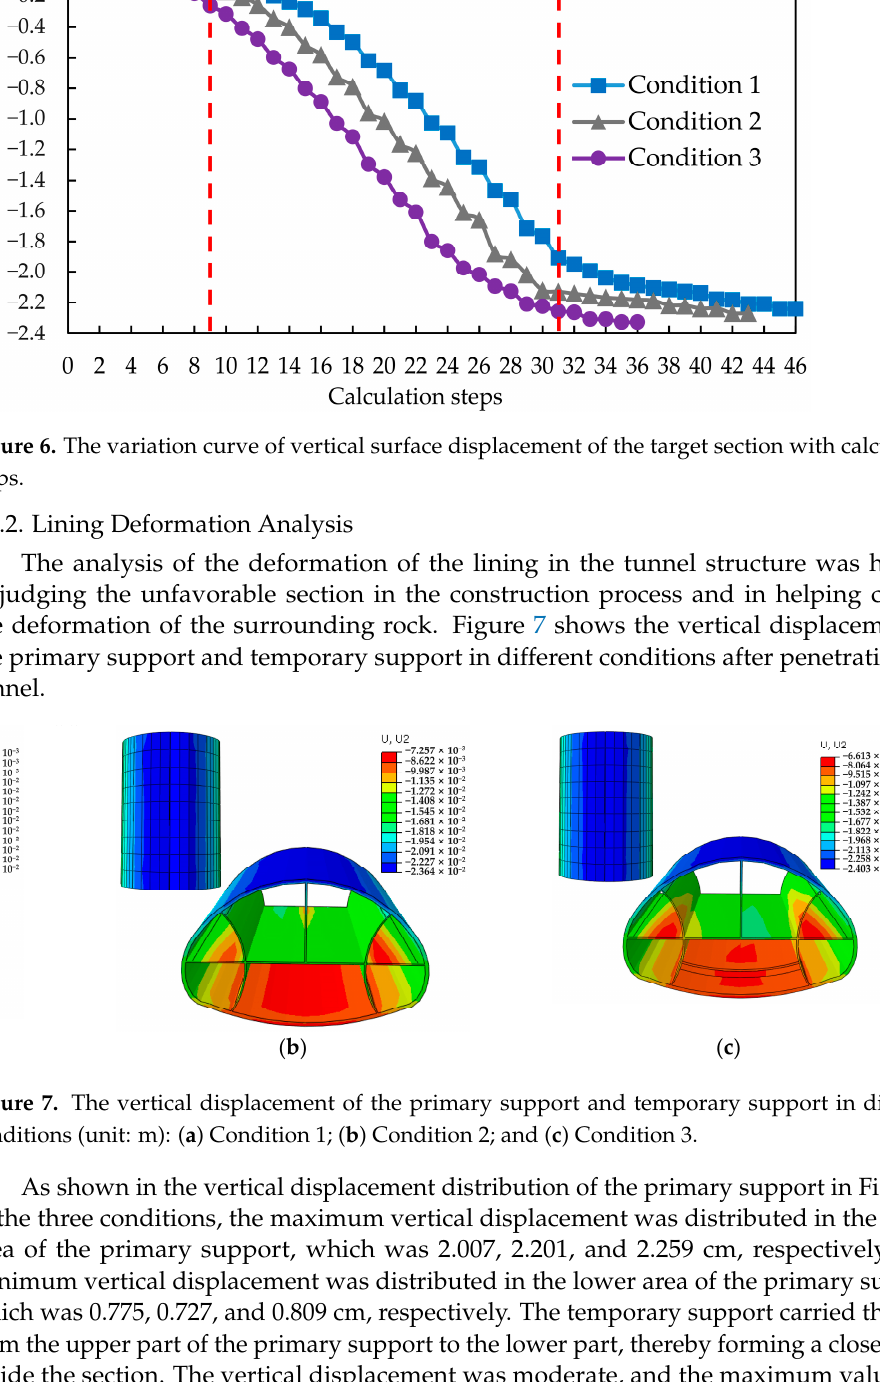
( d ) Figure 5. Vertical displacement of surrounding rock at the target section of rock mass part excava- tion under Condition 1 (unit: m): ( a ) Excavation of the right pilot tunnel; ( b ) Excavation of the left pilot tunnel; ( c ) Excavation of the upper part of the middle pilot tunnel; ( d ) Excavation of the lower part of the middle pilot tunnel. Figure 6 shows the variation curve of the vertical surface displacement of the target section with calculation steps in various working conditions. As seen in Figure 6, after the initial ground stress balance, the surface settlement gradually increased with the advance- ment of the palm surface, and three stages were divided by two red vertical lines. Before the 9th step of the calculation, the left and right pilot tunnels were excavated, whereas the middle pilot tunnel was not excavated yet, and the surface settlement increased slowly. Between the 9th and 31st steps of construction, the surface settlement occurred rapidly, and more than 90% of the total settlement was completed in this stage with the gradual advancement of each face of the middle pilot tunnel. After the 31st calculation step, the ground surface settlement increased slowly with the excavation of the lower part of the middle pilot tunnel because the upper part of the rock mass excavation was completed, and the lining structure of the middle tunnel was basically completed. The final surface settlement of Conditions 1, 2, and 3 was 2.23, 2.26, and 2.32 cm, respectively. The settle- ment of Condition 3 was the largest, which increased by 4.04% and 2.65% compared with